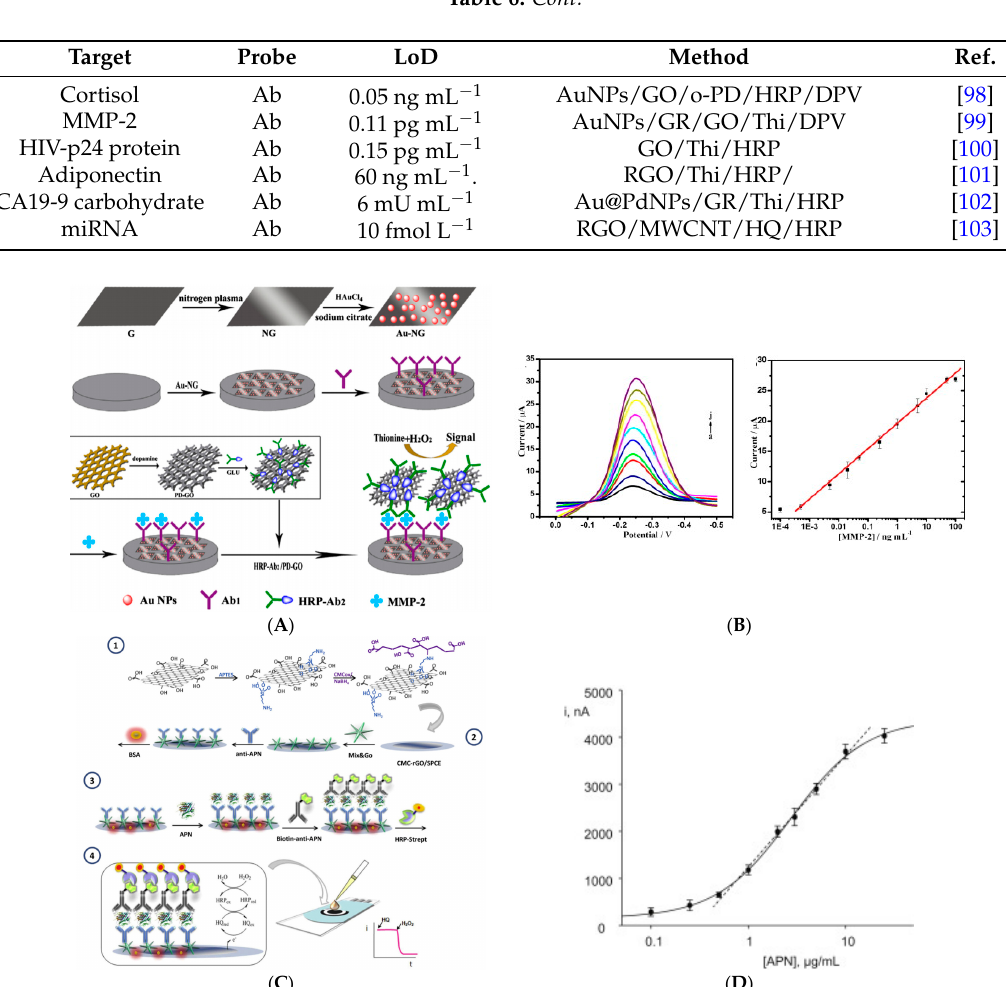
Figure 17. ( A ) Preparation and detection procedures for the MMP-2 immunosensor. Reprinted from [99], Copyright 2013, with permission from Elsevier; ( B ) Typical DPVs corresponding to MMP-2 concentrations from a to j (0, 0.0005, 0.005, 0.02, 0.05, 0.25, 1.0, 5.0, 10.0 and 50.0 ng mL − 1 ) in PBS + 4 mM H 2 O 2 , and corresponding calibration curve; ( C ) The different steps involved in the construction of the adiponectin (APN) immunosensor using a metallocomplex polymer (CMC) and RGO on a screen-printed carbon electrode; ( D ) Corresponding calibration plot. Reprinted from [101], Copyright 2016, with permission from Elsevier.